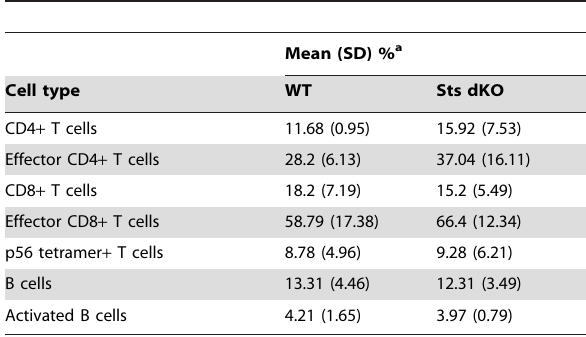
Table 1. Immune response in the lungs during acute infection.